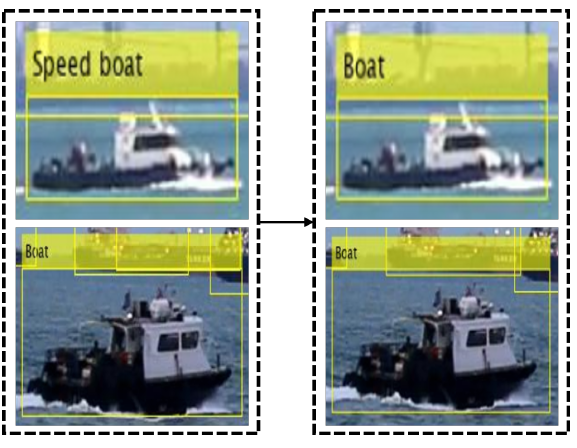
Figure 2. Integration of ‘Speed boat’ into ‘Boat’.